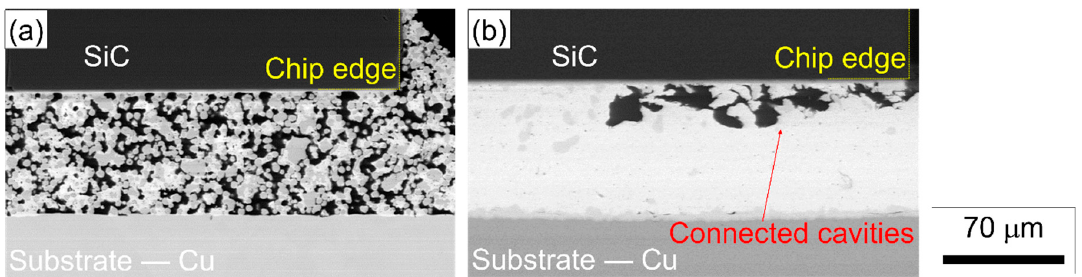
Figure 7. Unbonded area of TLPS and SAC305 solder joints through 1200 thermal cycles in the temperature range of –55 to 175 °C.